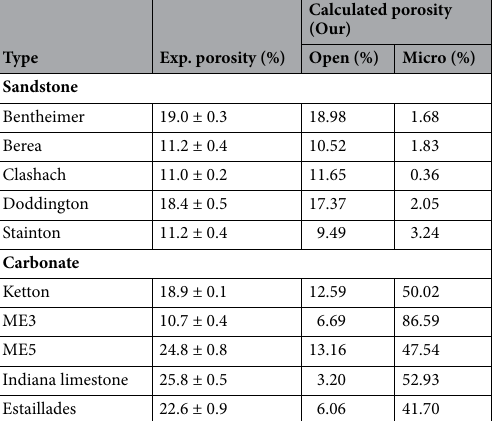
Type Exp. porosity (%)